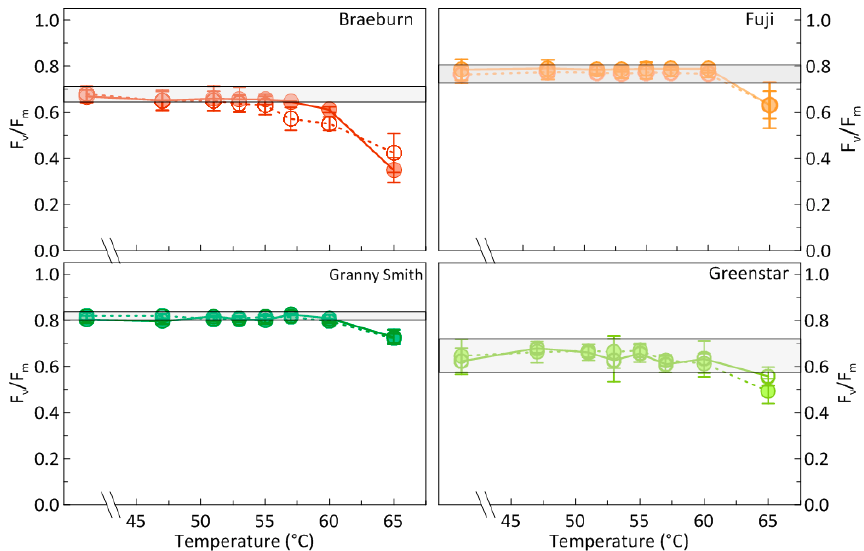
Figure 1. Means of the potential photon yield of photosystem II (F v / F m ) of ‘Braeburn’, ‘Fuji’, ‘Granny Smith’, and ‘Greenstar’ apples, hot-water-treated at temperatures ranging from 46 to 65 ◦ C for 30 s and measured one day (open circles, dotted lines) and eight days (filled circles) after the treatments. The light-grey horizontal bars indicate the standard deviation of results of the respective controls on day one of the experiment, roughly reflecting initial mean variability of F v / F m.